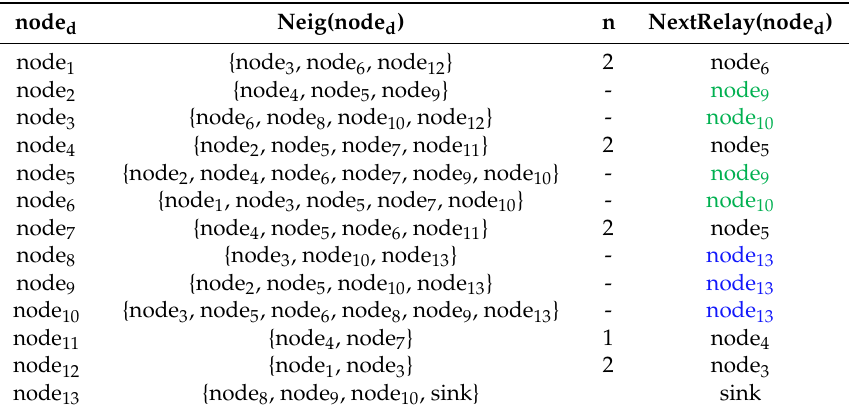
Table 2. Next relay node selection for position